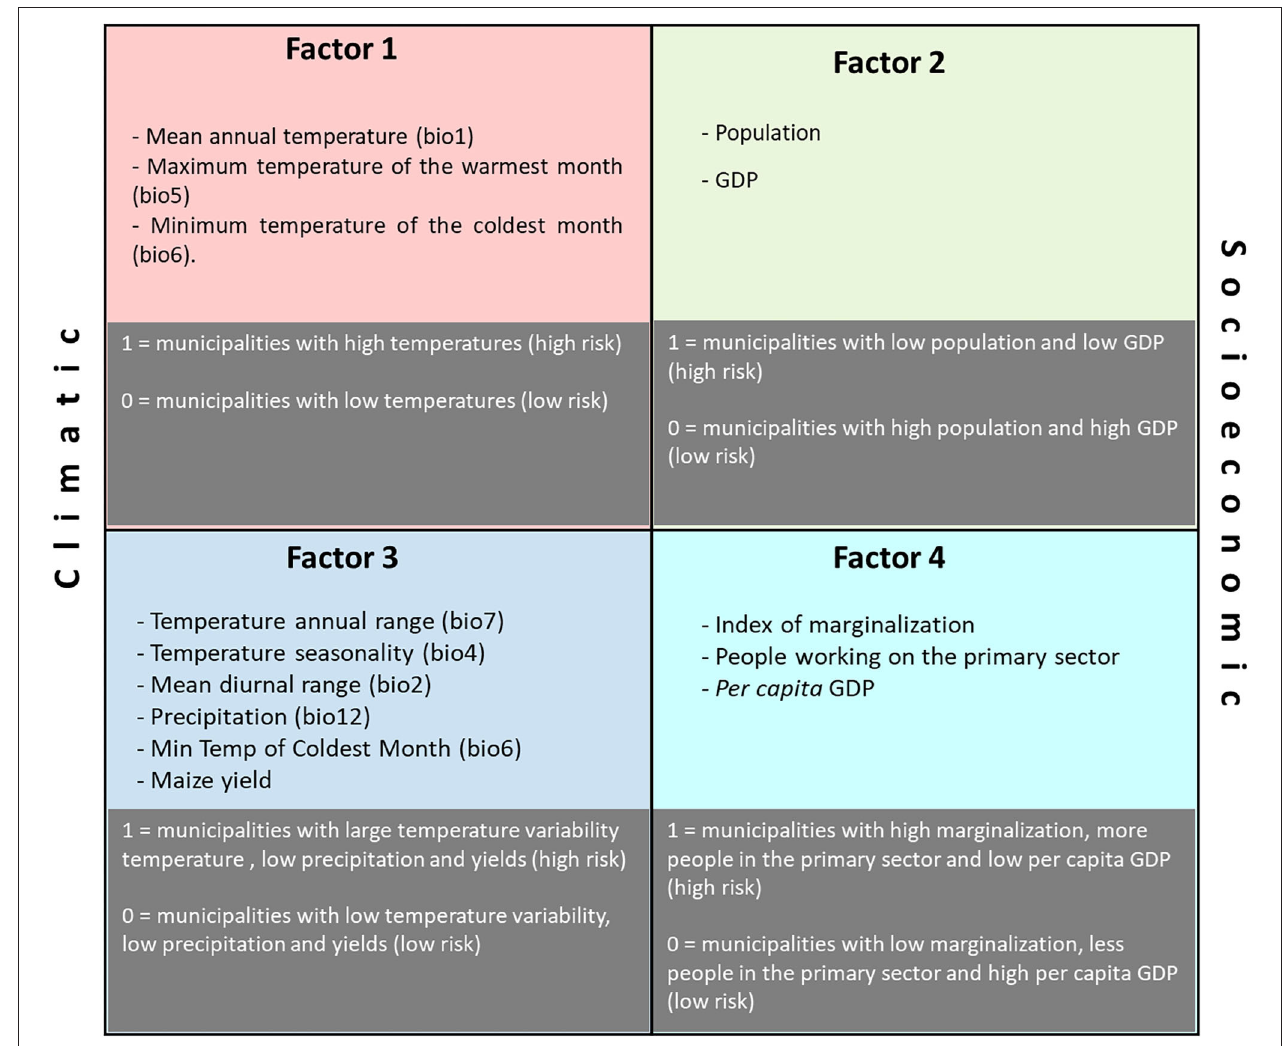
FIGURE 1 | Explanatory variables used in the PCA and the resulting factors. Gray rectangles explain the value given to the risk